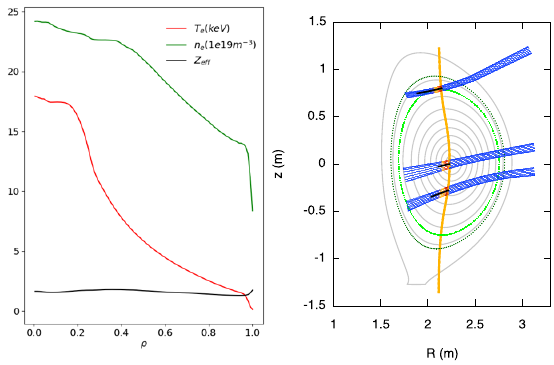
Fig. 1. (left) Electron density (green), electron temperature (red) and effective Z (black, with average Z eff ~1.6) profiles of the DTT full power scenario, used as input in beam tracing simulations. r is calculated as the squared root of the normalized toroidal flux. (right) Poloidal projection of the flux surfaces and of the path of different EC beams varying the launching position/angles. In yellow the resonance layer for 170 GHz. In (dark) green the poloidal projection of the q=3/2 (q=2/1) surface, located at r =0.701 ( r =0.814).